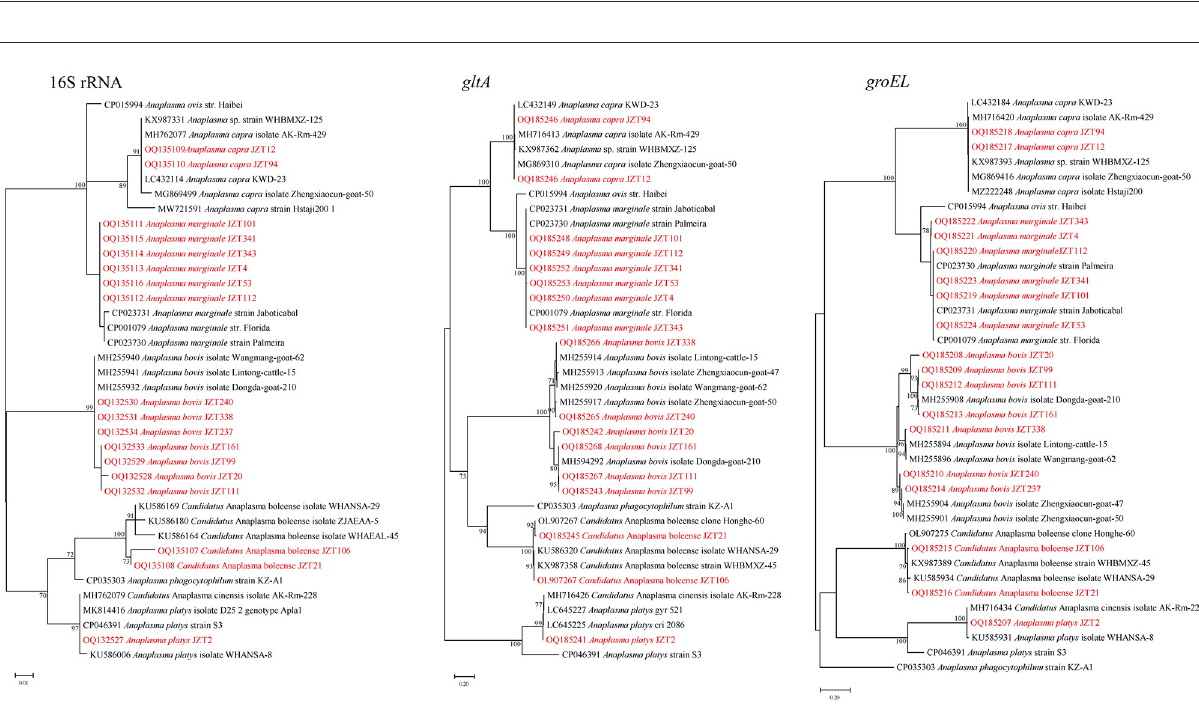
detected in H. longicornis, R. microplus, and H. hystricis, with positive rates of 7.1% (39/549), 0.4% (1/246), and 9.1% (5/55), respectively. The 16S rRNA, gltA , and groEL genes showed 99.55– 99.89%, 92.66–99.66%, and 95.83–99.72%, respectively,